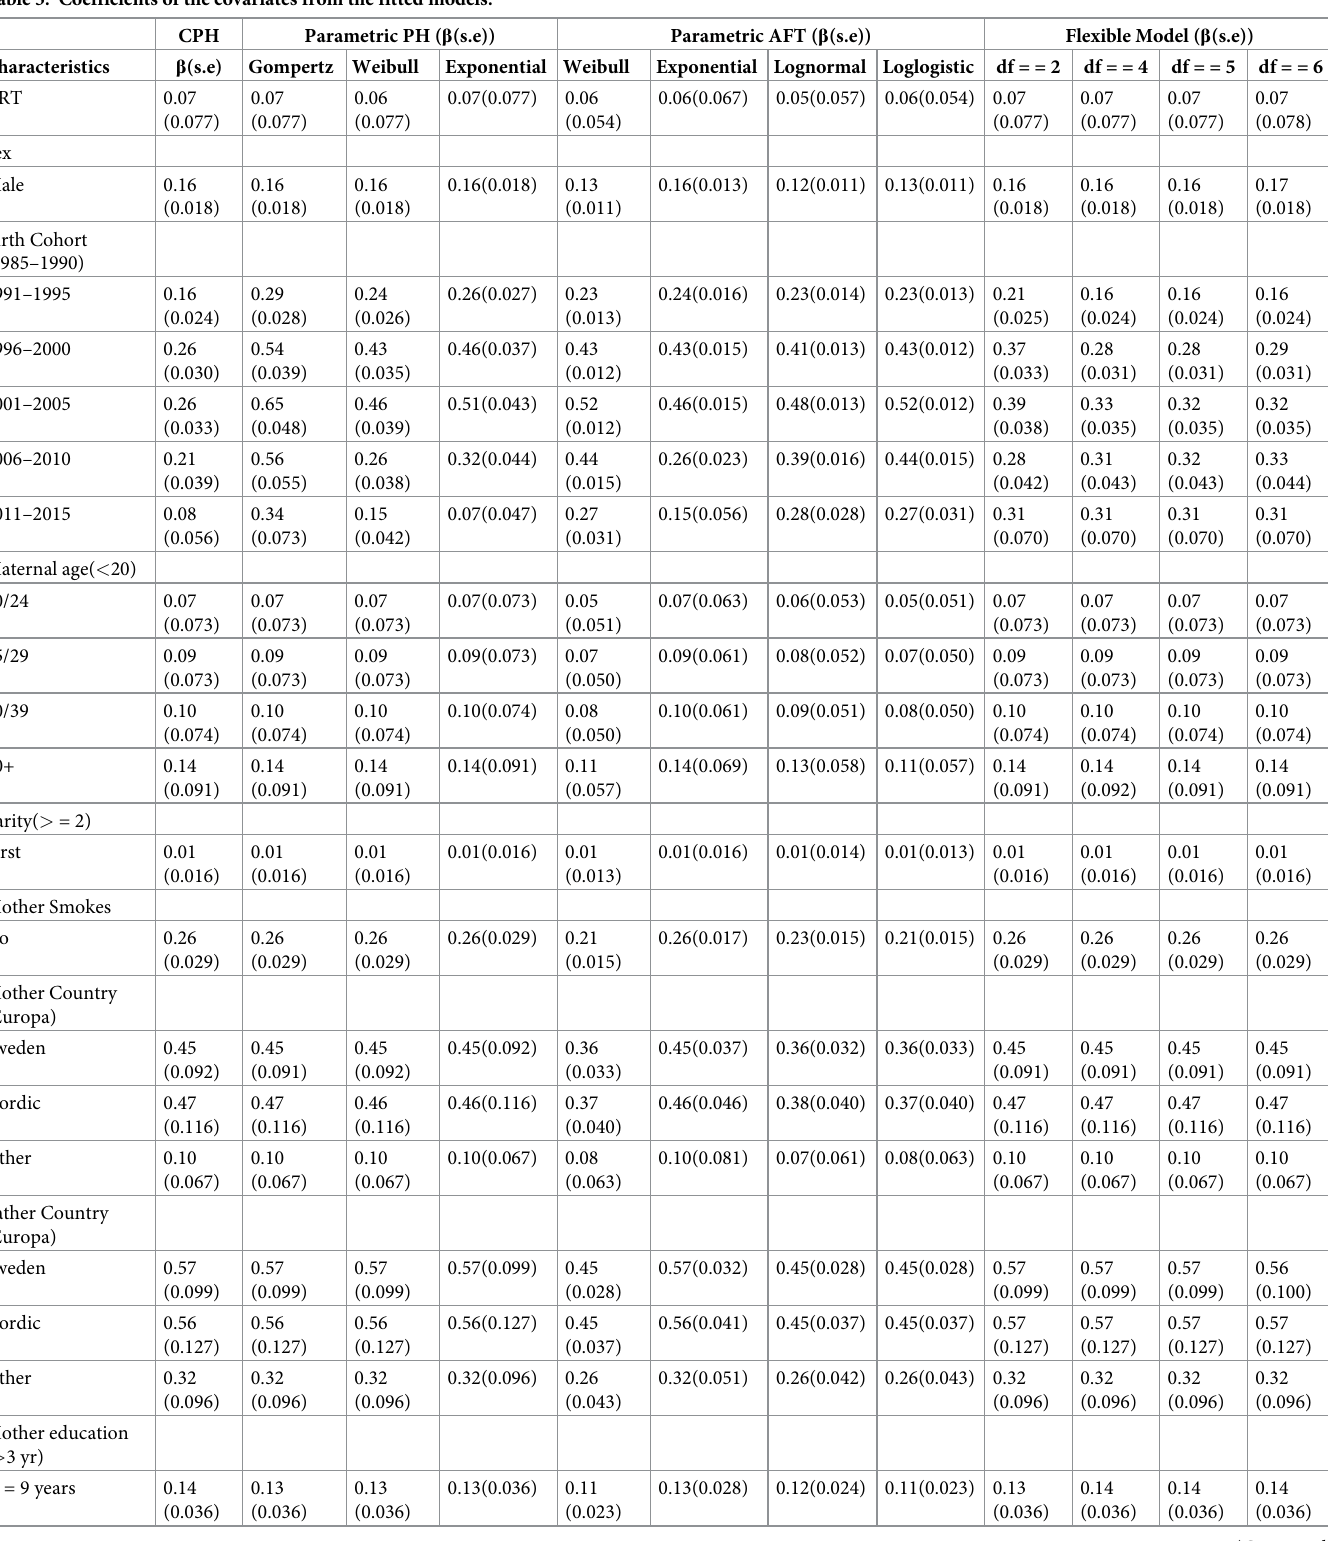
Table 3. Coefficients of the covariates from the fitted models. CPH Parametric PH ( β (s.e)) Parametric AFT ( β (s.e)) Flexible Model ( β